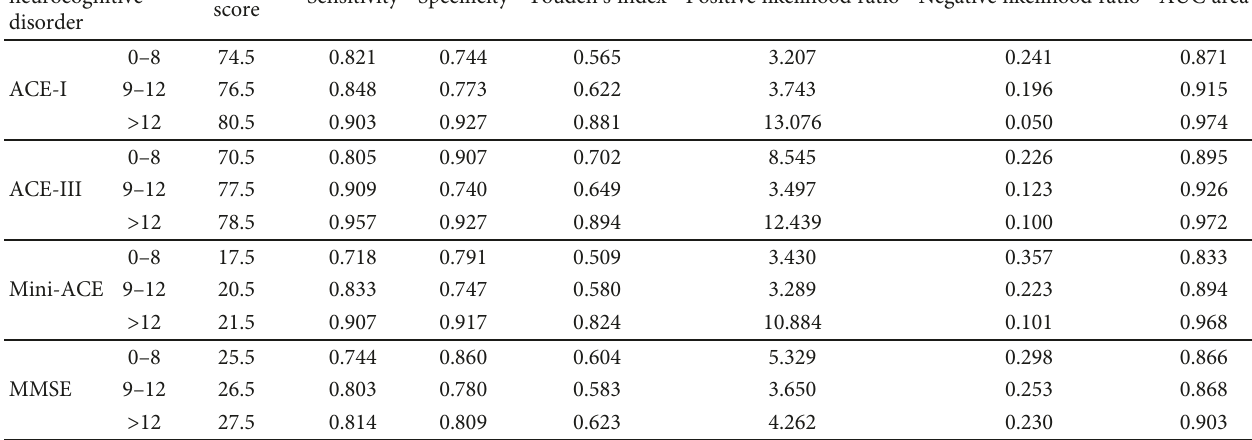
Table 3: Diagnostic accuracy of ACE-I, ACE-III, Mini-ACE, and MMSE for detecting major neurocognitive disorder in the respect of education